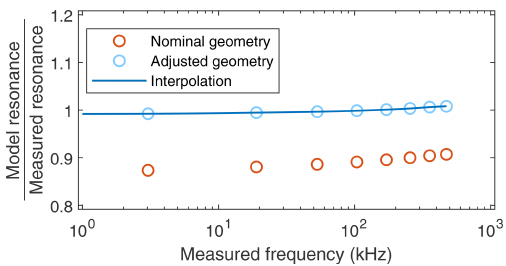
Figure 8. Resonance frequencies of the model in relation to the measured values. Nominal values are calculated using the geometry of the sensor given in the datasheet, and adjusted values are calcu- lated after adjusting the geometry to minimize the error. Addition- ally, a compensating curve is shown which is used for subsequent calculations.